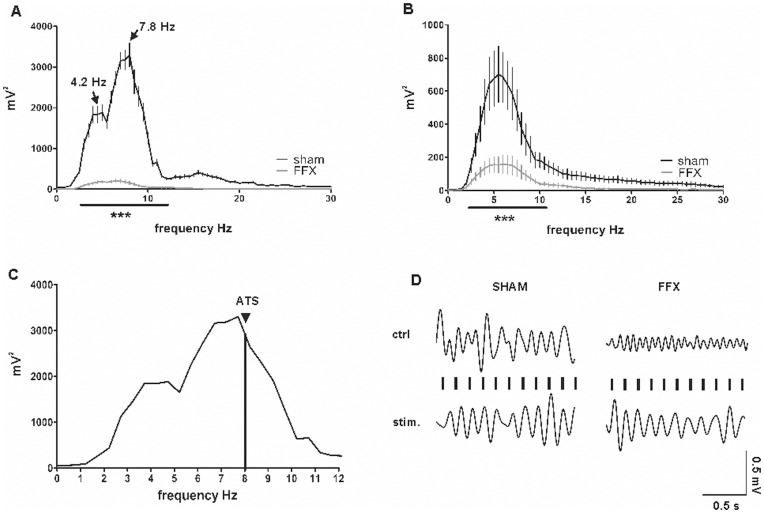
The EEG analysis revealed the effect of the fimbria-fornix lesioning on theta frequency range (4–12 Hz, marked with a horizontal bar) in the septal CA1 area during exploration (A) and freezing (B).The lines represent the spectral analysis of EEG of the sham operated (n = 7) and the FFX (n = 6) group. The error-bars represent SEMs, and asterisks denote frequency bands with significant differences at the level P<0.01. (C) Zoomed-in presentation of the same power analysis of sham-operated animals during exploration as in (A). The vertical line denotes the frequency of ATS (8.0 Hz) that was slightly above the mean peak frequency (7.8±0.2 Hz) of sham animals during exploratory behavior. (D) Examples of filtered (2–12 Hz) hippocampal EEG related to exploratory behavior in a sham-operated and a fimbria-fornix lesioned animal during both control situation and artificial theta stimulation (ATS). The occurrence of stimulation pulses is shown on top of the sample EEG sweep.